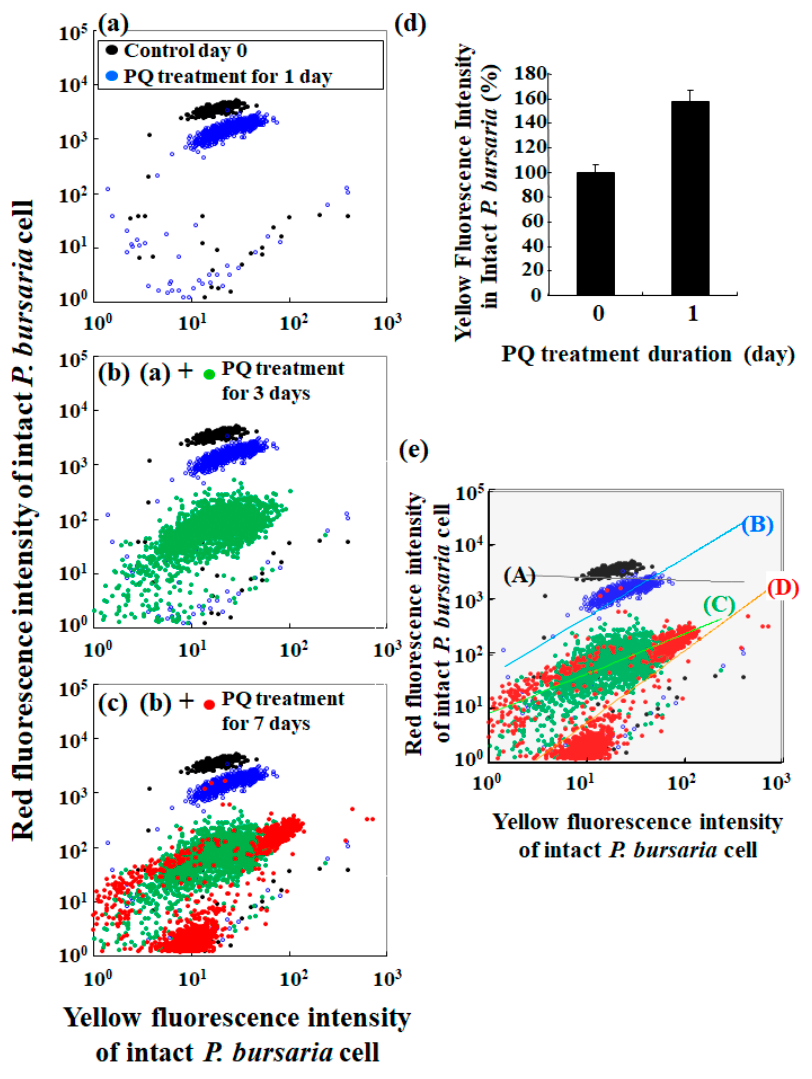
Figure 3. Characteristics of red and yellow fluorescence intensities of P. bursaria cells analyzed using FCM. ( a – c ) Scatter plots of yellow fluorescence intensity vs. red fluorescence intensity of P. bursaria cells treated or not (control, day 0) with PQ (0.1 µ g/mL). ( d ) Difference in yellow fluorescence intensity of untreated and PQ-treated (1 d) P. bursaria cells. Data were expressed as mean ± standard error ( n > 320 signals [320 cells of intact P. bursaria ]). ( e ) Slop analysis of scatter plots for P. bursaria treated or not with